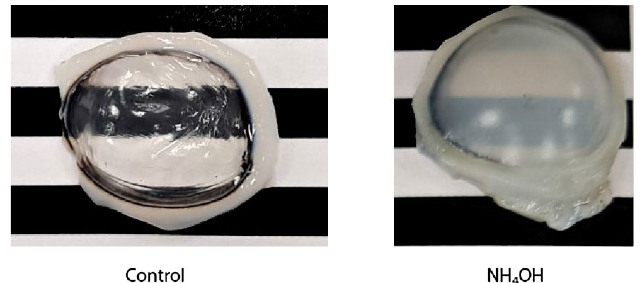
Figure 2. Porcine corneal samples from the control and treated groups. The background pattern evidenced structural changes that ammonium hydroxide ( NH 4 OH)